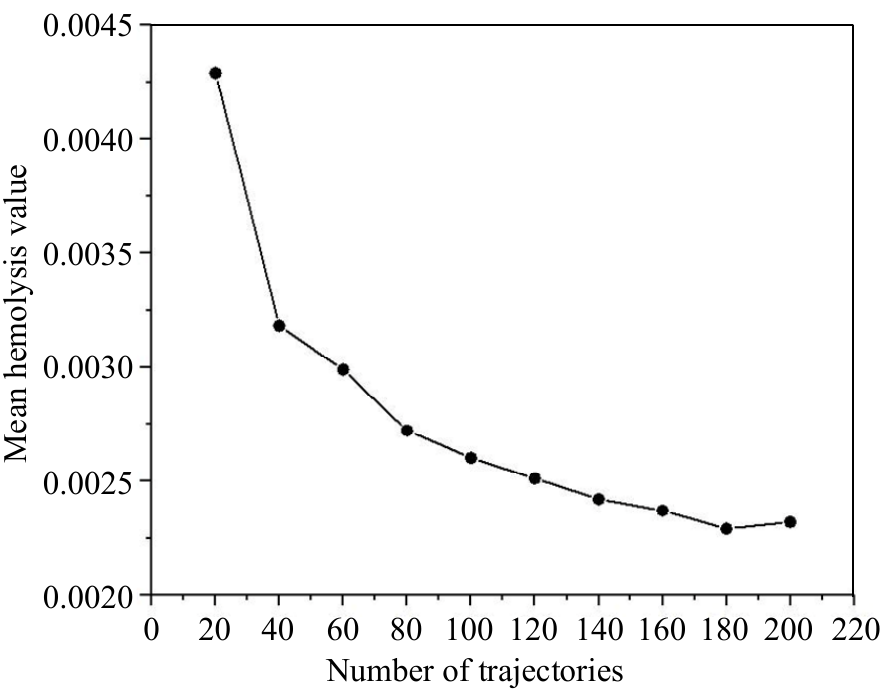
Figure 12. Trajectory independence verification.